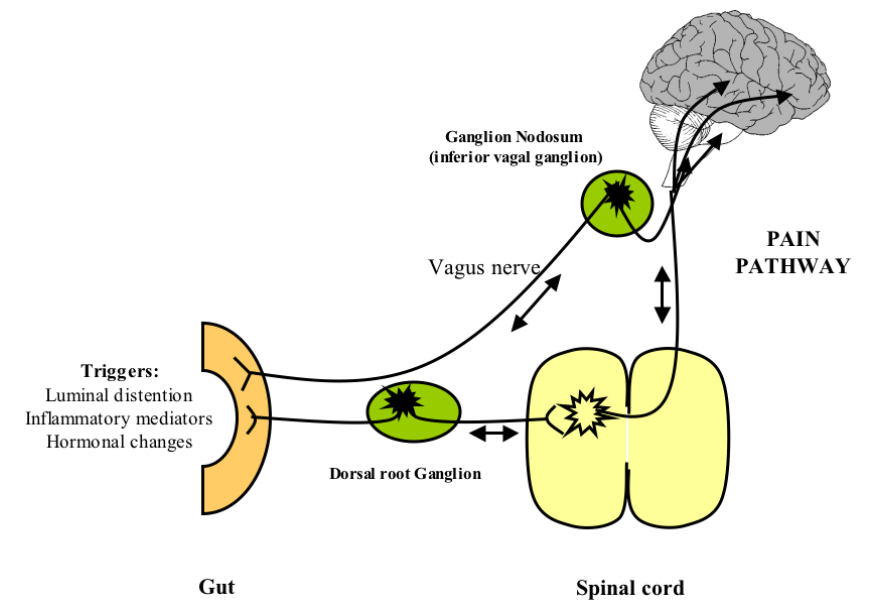
FIGURE 2 . Diagram showing the extrinsic system of the brain-gut